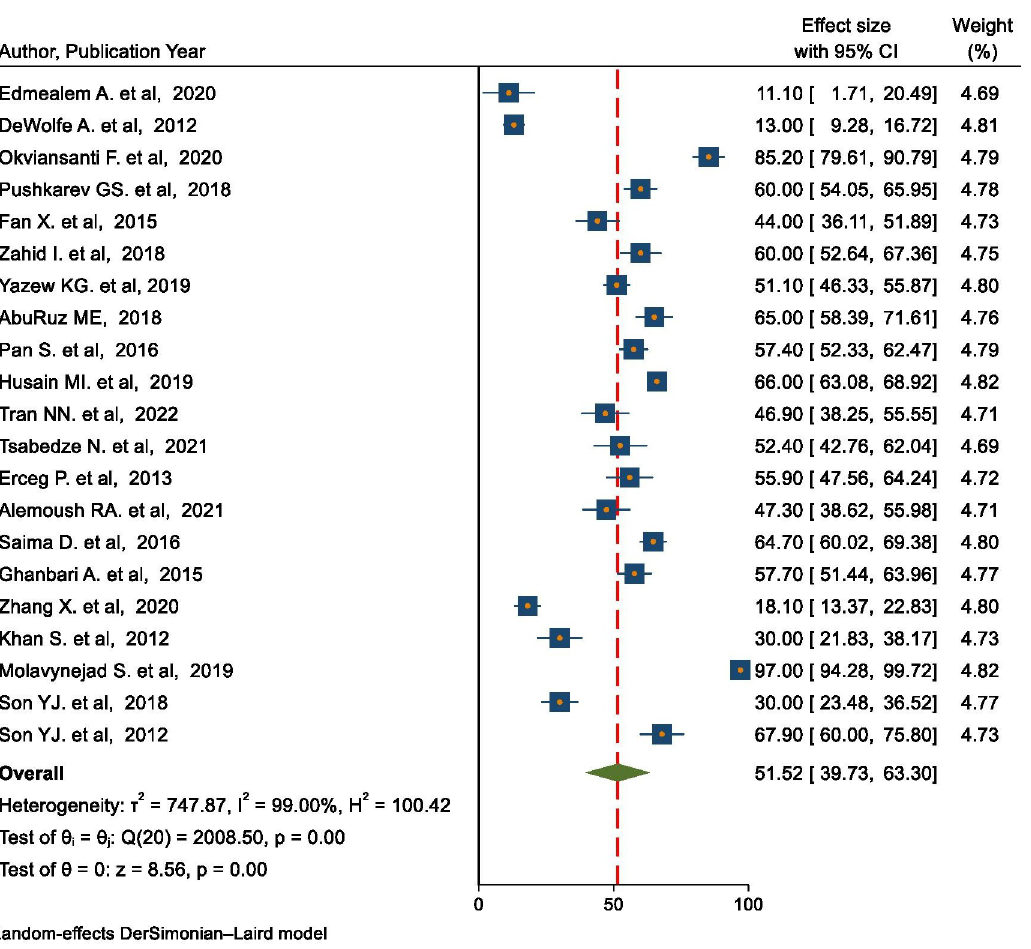
Fig 2. The pooled prevalence of depression in people with heart failure in